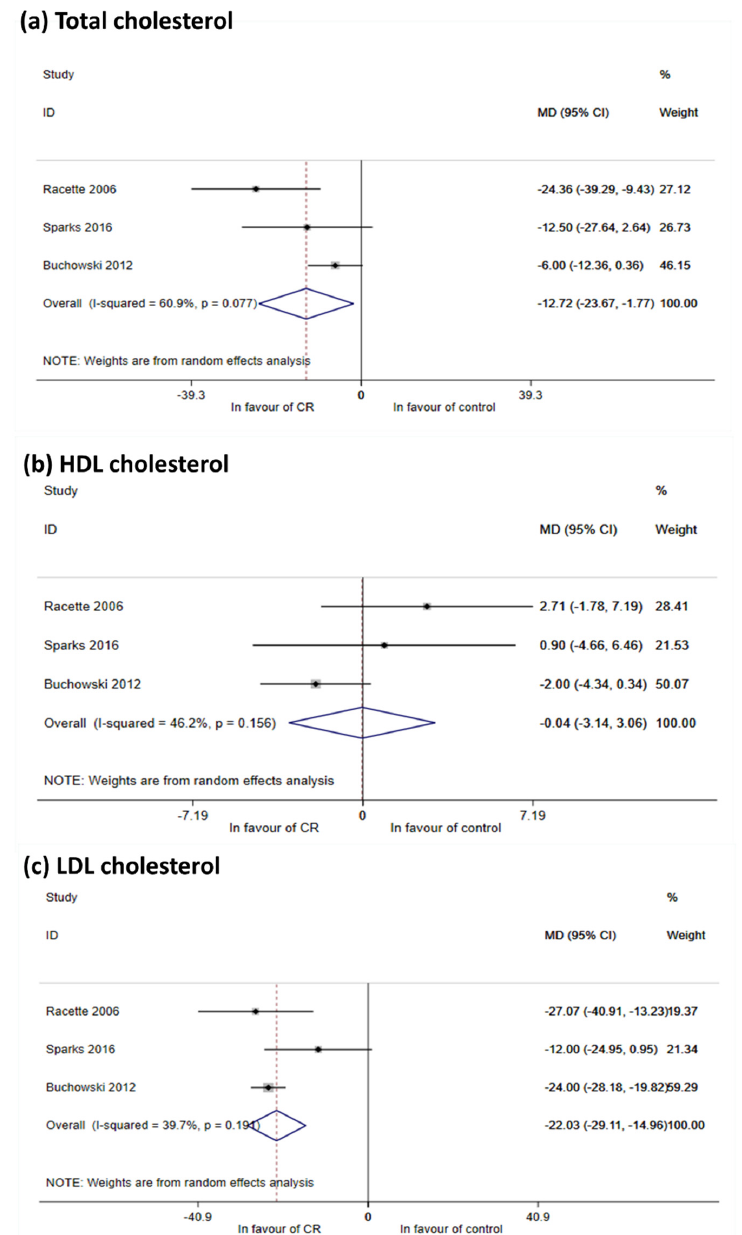
Figure 3. Meta-analysis for LDL, HDL and total cholesterol. ( a ) Meta-analysis using random e ff ect method, outcome Total cholesterol . Meta-analysis was performed using post mean value (or median value) or mean change within groups and calculating mean di ff erences (MD, with their 95% CI). Despite the moderate heterogeneity, meta-analysis shows that CR is e ff ective in total cholesterol reduction All MDs are expressed in mg / dL; ( b ) meta-analysis using random e ff ect method, outcome HDL cholesterol. Meta-analysis was performed using post mean value (or median value) or mean change within groups and calculating mean di ff erences (with their 95% CI). Mean estimate is in favor of control, but non statistically significant. Only Racette 2006 showed an iatrogenic e ff ect of CR. All MDs are expressed in mg / dL; ( c ) meta-analysis using random e ff ect method, outcome LDL cholesterol. Meta-analysis was performed using post mean value (or median value) or mean change within groups and calculating mean di ff erences (with their 95% CI). Impact on LDL reduction is showed considering all studies together. Heterogeneity is moderate. All MDs are expressed in mg /